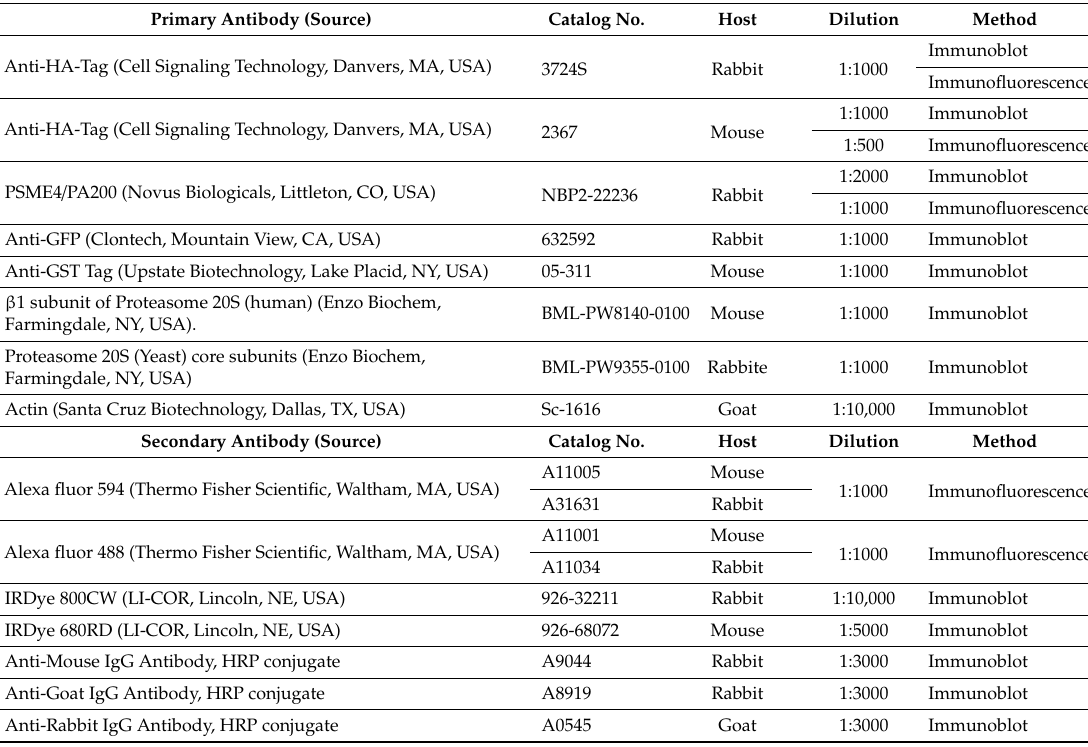
Table 2. List of primary and secondary antibodies used in this